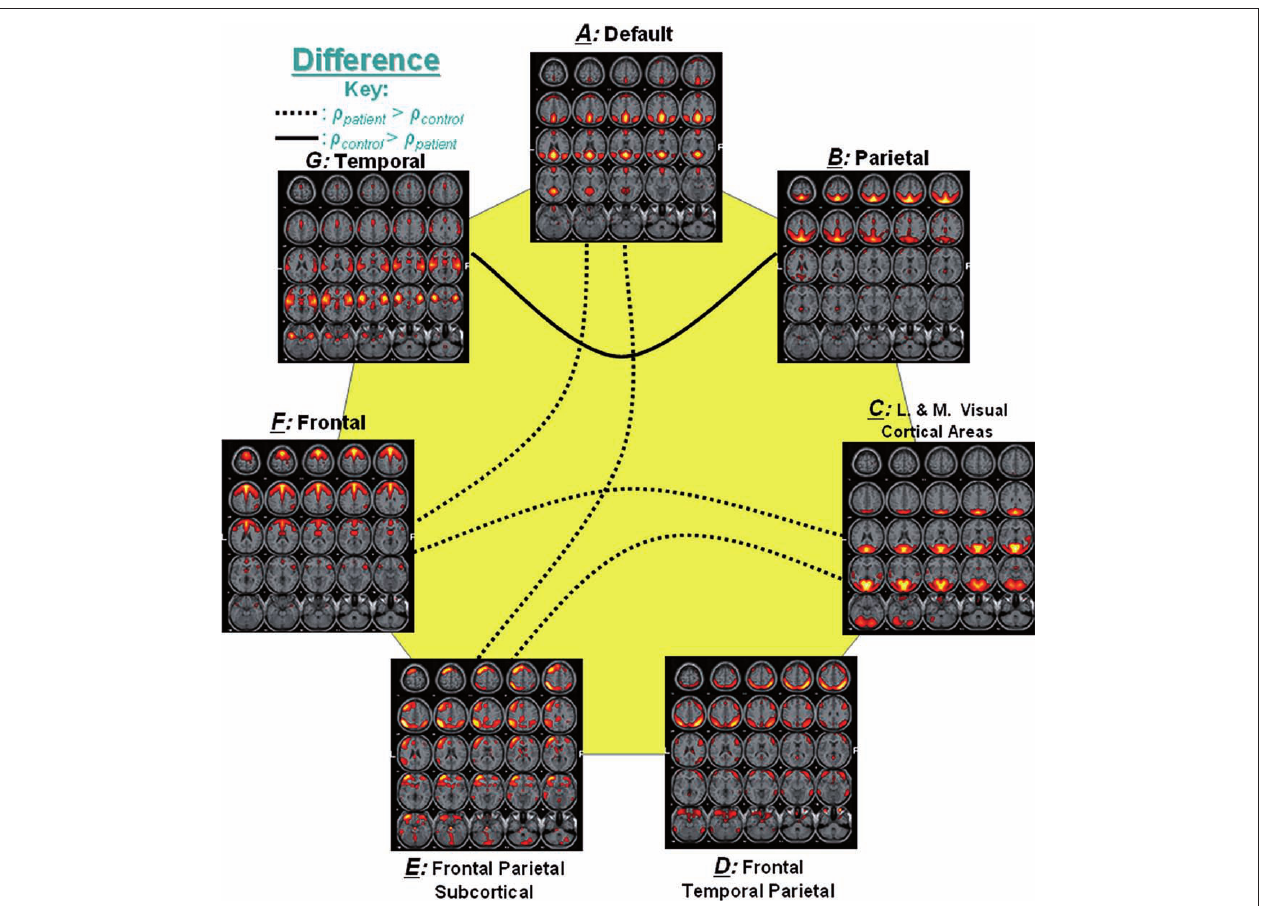
mean correlation than patients, while dotted line represents connectivity where patients have higher mean correlation. Presence of dotted lines rejects the hypothesis that controls should have more correlation between two components than